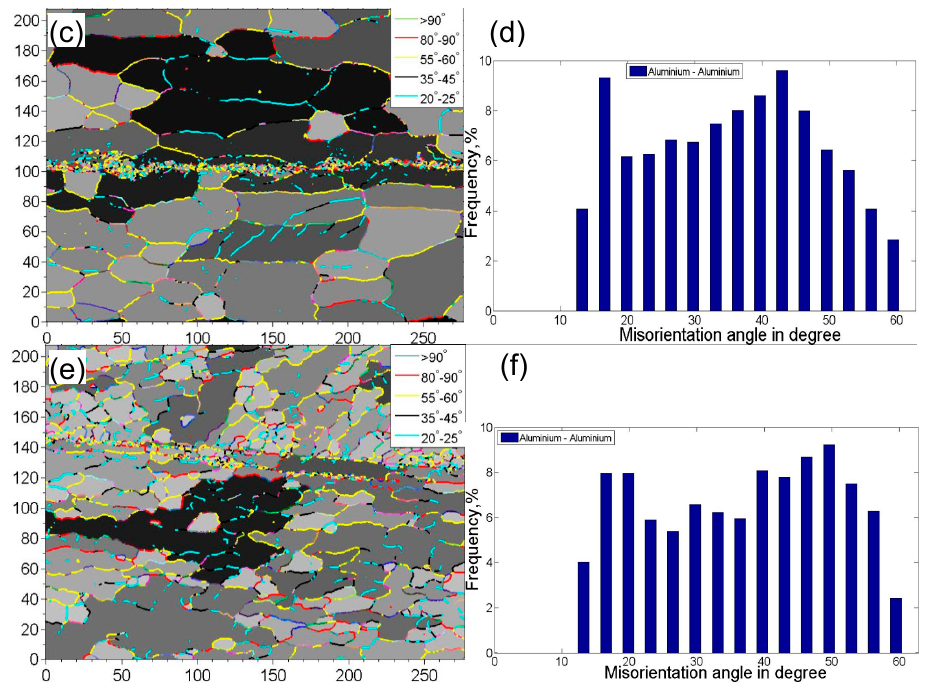
Figure 3. Grain boundary mapping along with the misorientation angle distribution of the 6022-T43 Al alloy. ( a , b ) BM; ( c , d ) the USWed joint made with a welding energy of 800 J; and ( e , f ) the USWed joint made with a welding energy of 1400 J.